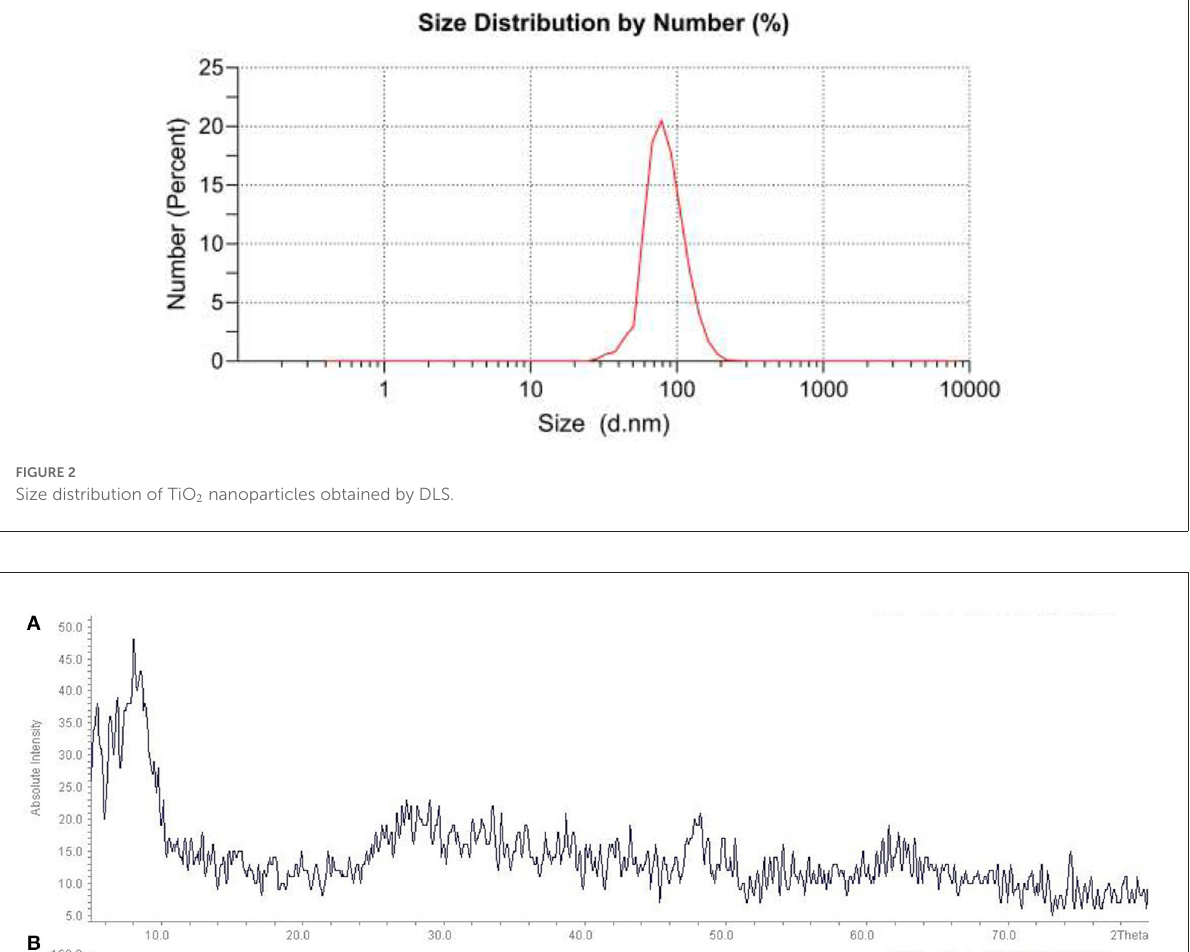
fabric on the nature of the prepared TiO 2 nanoparticles (27,